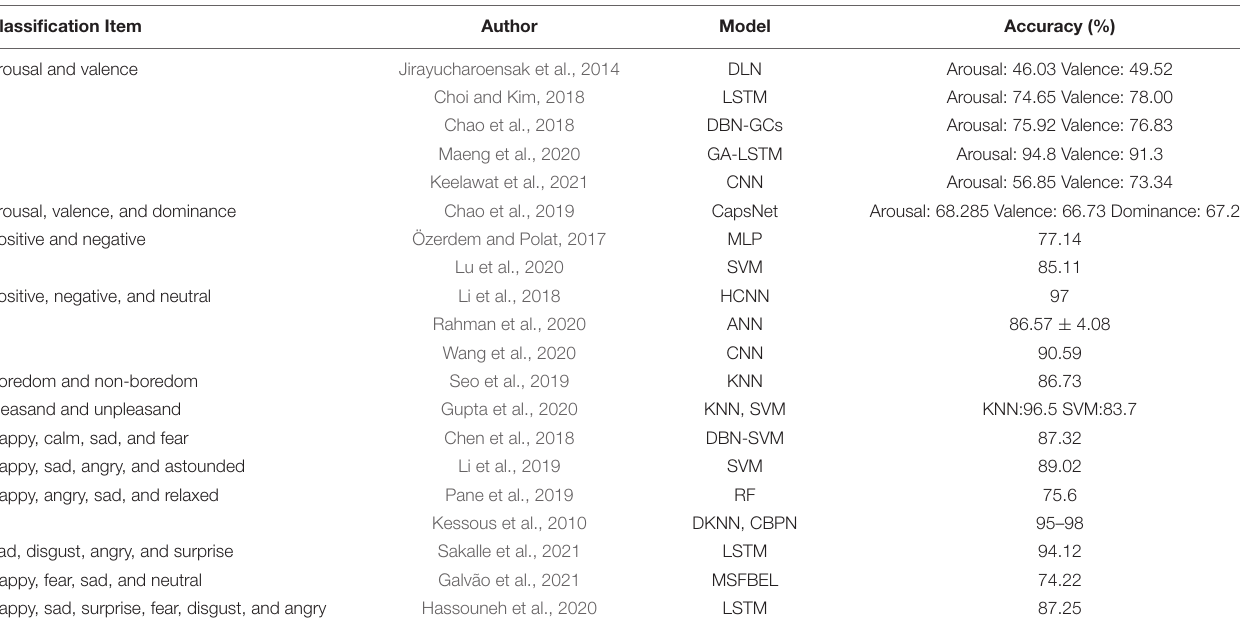
TABLE 1 | Classifiers and their